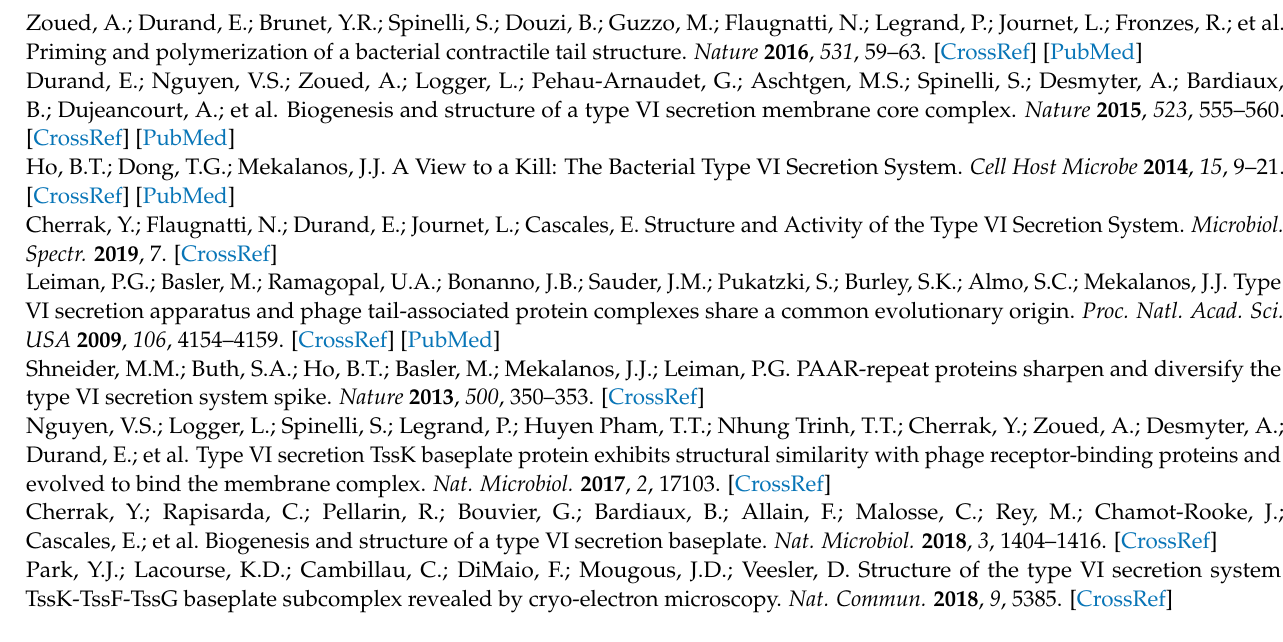
tion of the Tle3 AIEC /Tli3 AIEC complex; Figure S4: AlphaFold2 pLDDT and PEA plots; Figure S5: Schematic strategy of molecular replacement; Table S1: Data collection and refinement statistics.; Table S2: Plasmids and